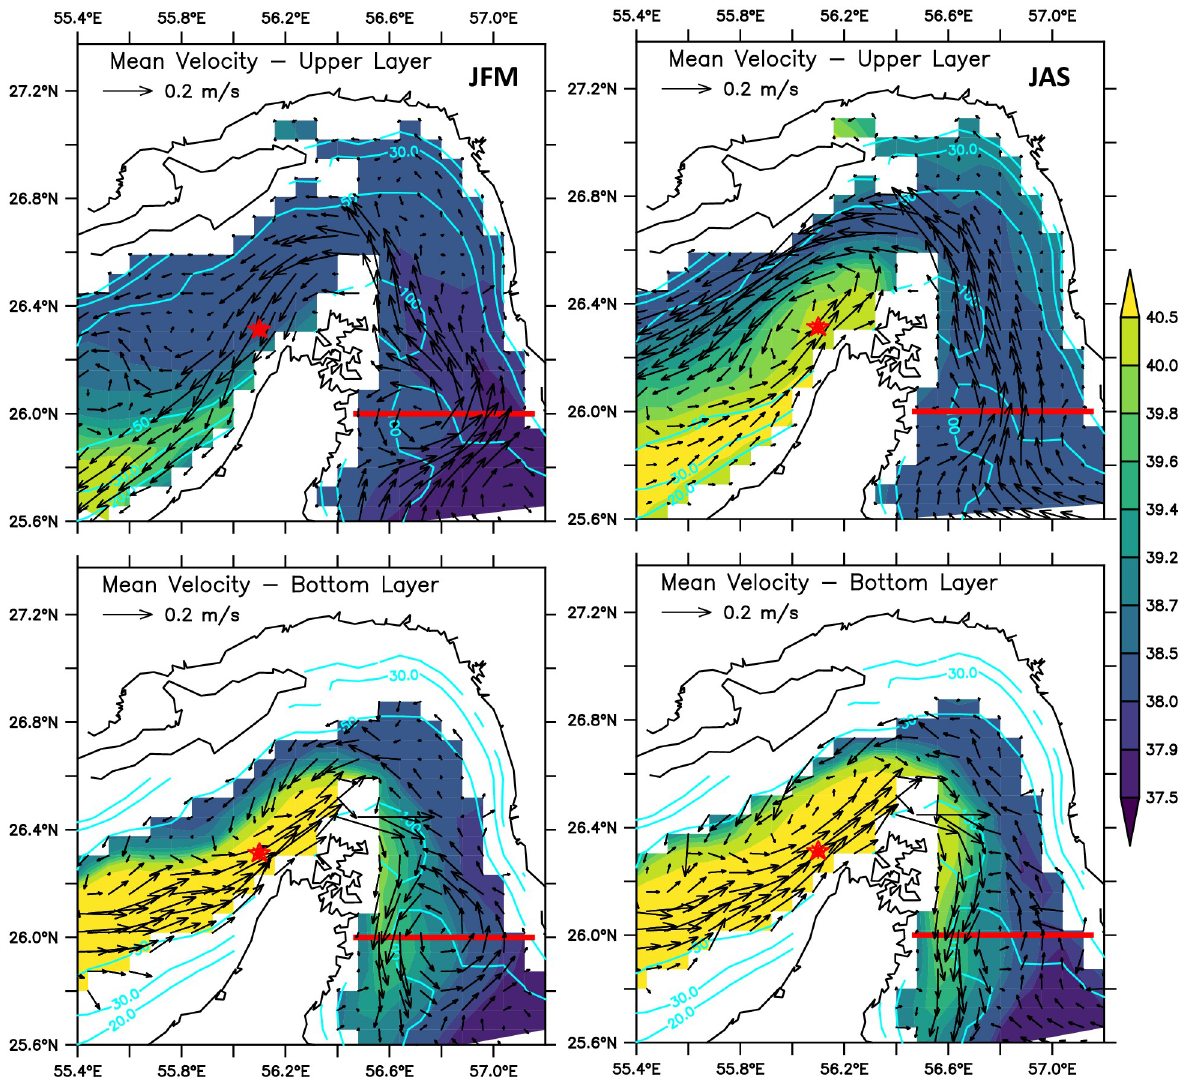
Fig 6. Salinity and velocity distributions for Winter (JFM) and Summer (JAS), in the upper (top panels) and lower layers (bottom panels), in the region encopassing the Strait of Hormuz. The red star indicates the [3] mooring site. The thick red line along 26˚N, from 56˚50’E to 57˚10’E indicates the zonal section where some diagnostic are coomputed in the following